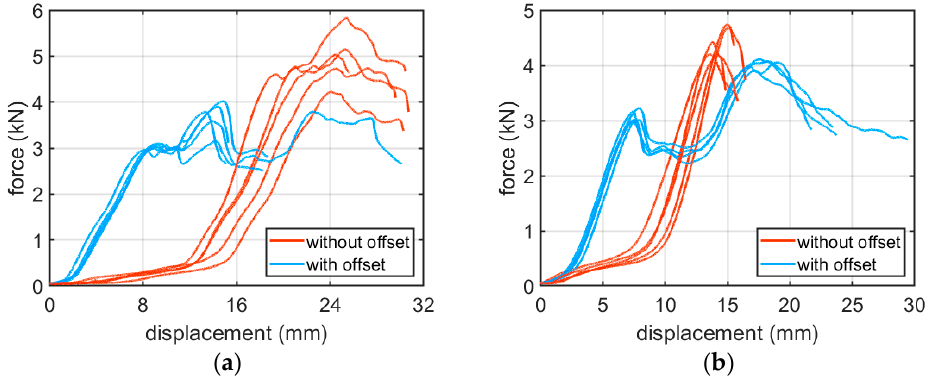
Figure 10. Selected measurements from a BCT press for grades: ( a ) BC-780; ( b ) EB-965.